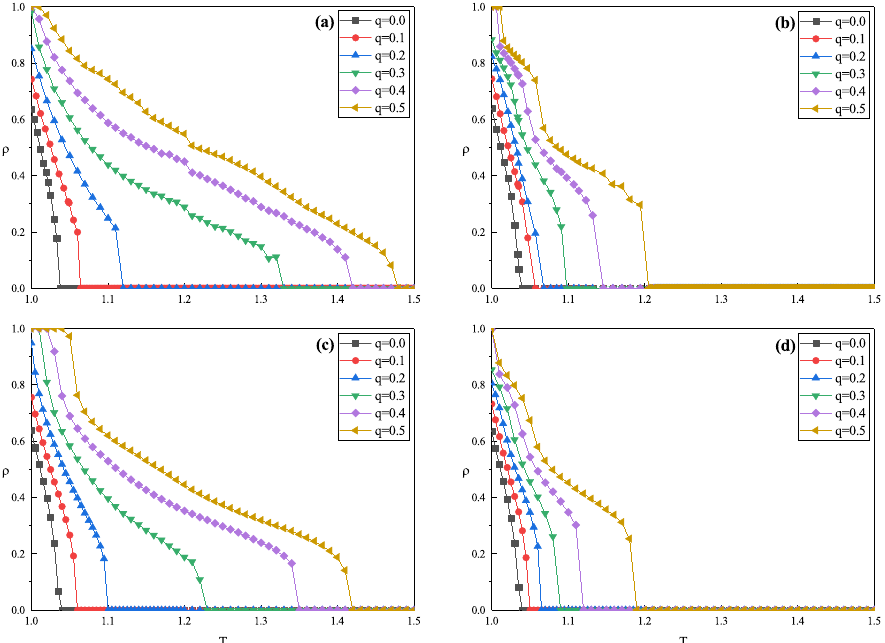
Figure 1. Fraction of cooperators ρ at the stationary state as a function of T on a square lattice for different values of q , n and c . From panel ( a – d ), n and c are set to be as follows: ( a ) n = 12, c = 0.1; ( b ) n = 12, c = 0.01; ( c ) n = 8, c = 0.1; ( d ) n = 8, c = 0.01. Other model parameters are fixed as: L = 100, K =